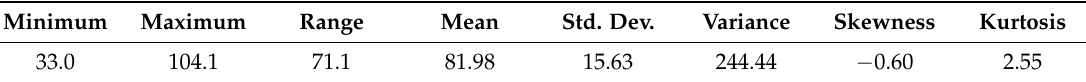
Table A1. Statistics of the air outlet relative humidity distribution [%].